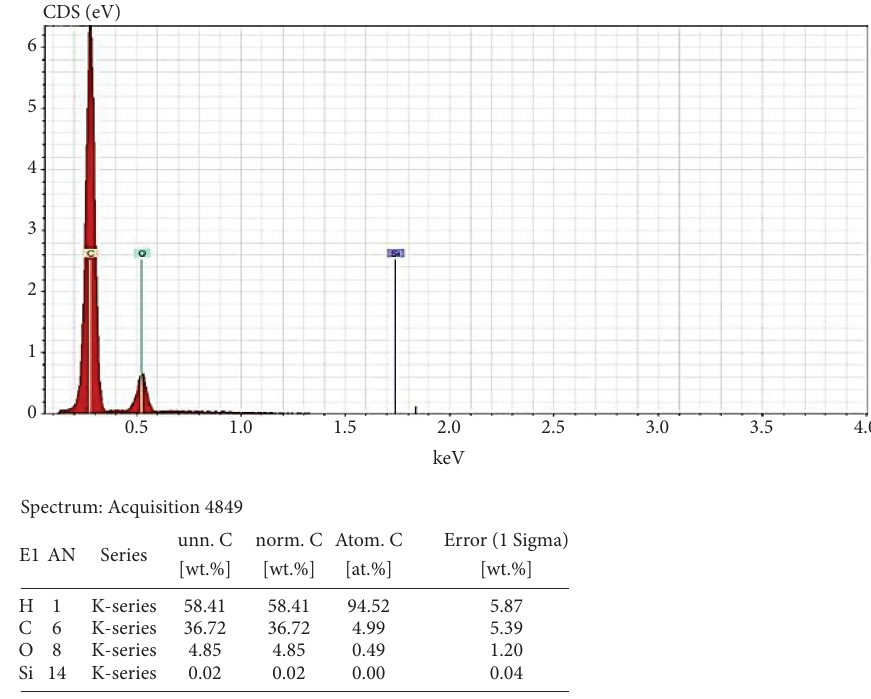
Figure 3: EDX image for the PEEK and SiO